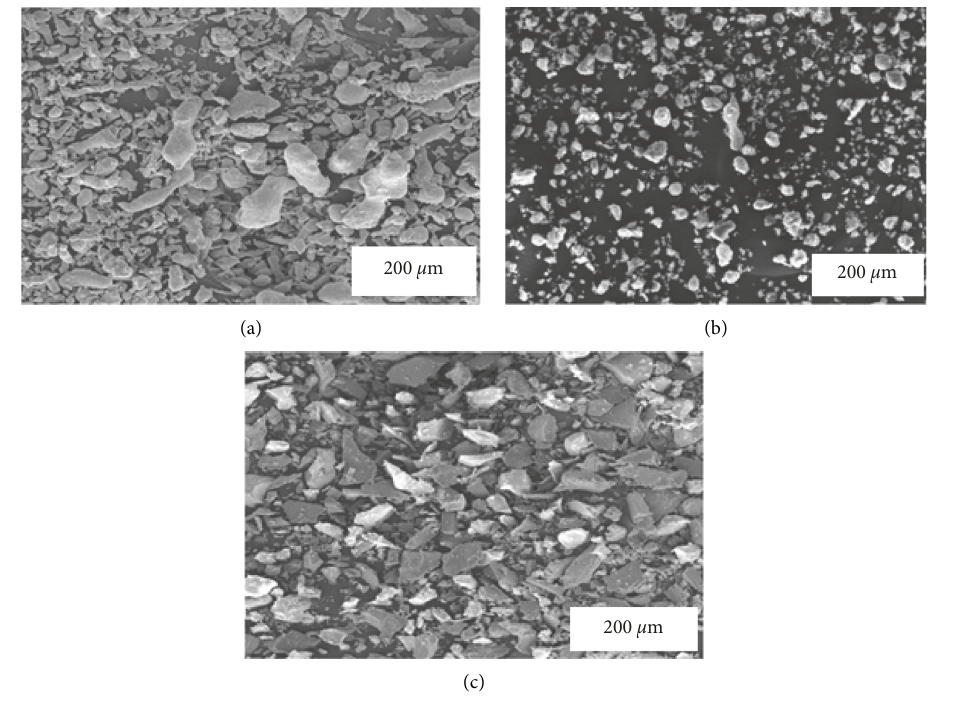
Figure 1: SEM morphology of (a) Al 6061, (b) AlN, (c) SiC. Table 1: Chemical composition of the matrix (Al6061 alloy) [7, 9, 13].